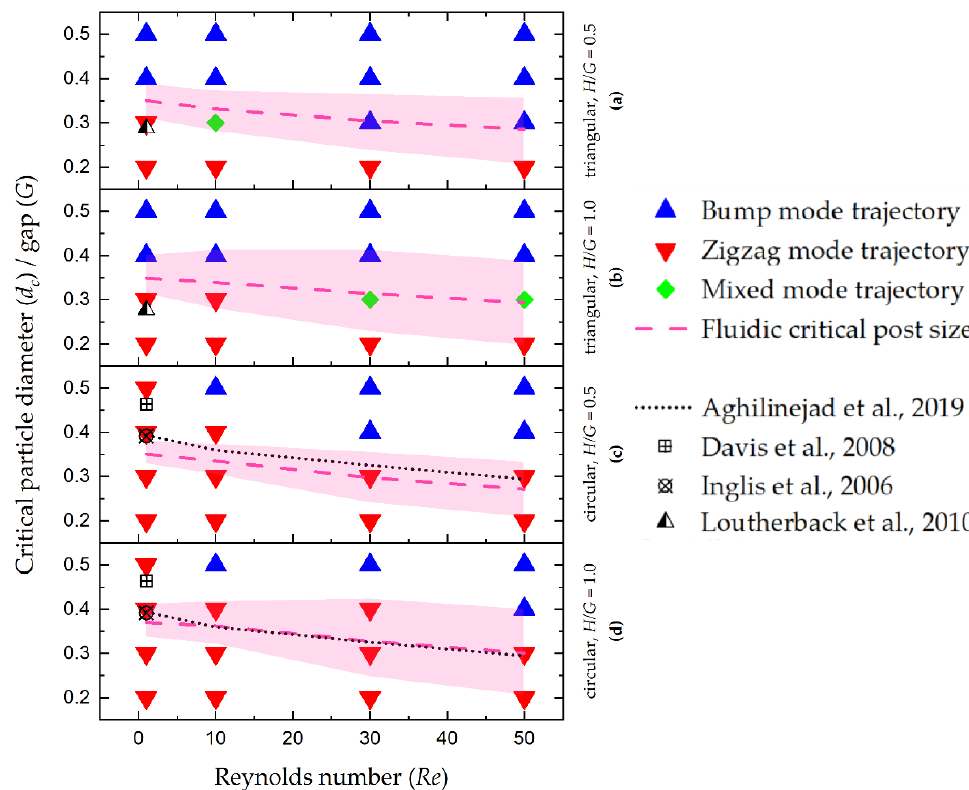
Figure 7. The determined critical particle diameters ( d c ) are presented in relation to the gap size and compared with the literature. The results are differentiated by post shape (circular and equilateral triangular), as well as ratio of post height to gap, H / G , and are plotted against the Reynolds number. The mean values determined from the first streamline widths from CFD simulations are shown as dashed lines in purple. Since d c varies locally, the areas bounded by minima and maxima around the mean values are colored area-wise. The measurement points represent the results of the coupled CFD-DEM simulations and show in color whether the corresponding particle sizes have followed a zigzag, bump or mixed path under the given conditions.